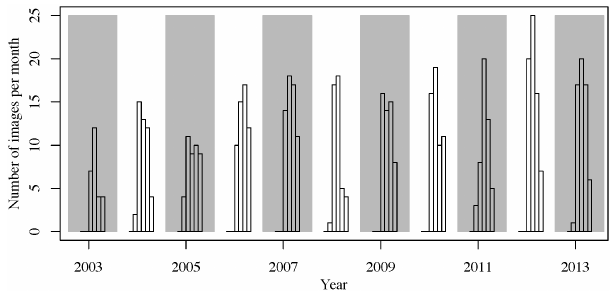
Figure 4. Number of Level-2 images available for each month of the time series (images selected after visual